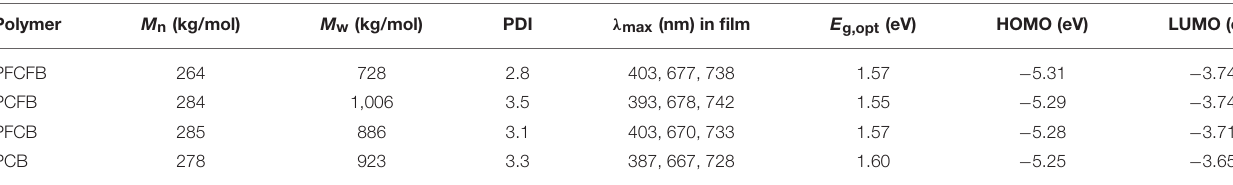
TABLE 1 | The physical, optical, and electrical properties of polymers. Polymer M n